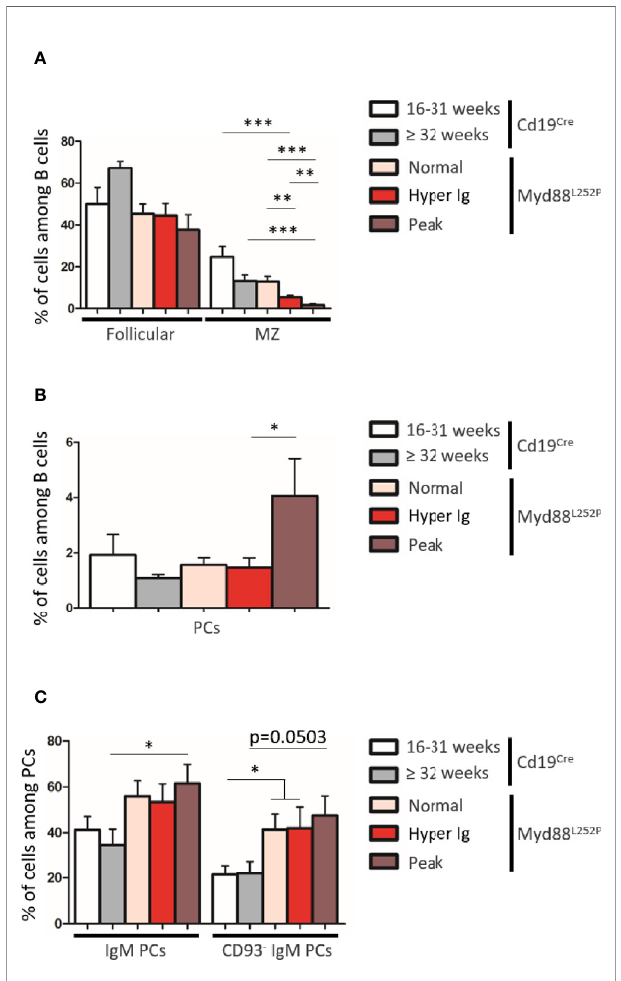
FIGURE 6 | B-cell differentiation in spleens from Cd19 Cre and Myd88 L252P mice. (A) Percentage of Follicular B cells (CD21 pos CD23 high ) and marginal zone (MZ) B cells (CD21 high CD23 pos ). (B) Percentage of plasma cells (PCs, B220 low CD138 high ). (C) Percentage of IgM + PCs and CD93 neg IgM PCs. Myd88 L252P mice (with normal SPE: n = 7; with hyper Ig: n = 10; with Ig peak: n = 9) were compared to Cd19 Cre mice LMCs (16-31 week and ≥ 32 week-old mice; n = 9 for each group) Results are presented as the mean ± SEM. Mann Whitney test p-value < 0.05, p-value < 0.01 and p-value < 0.001 are symbolized by *, ** and